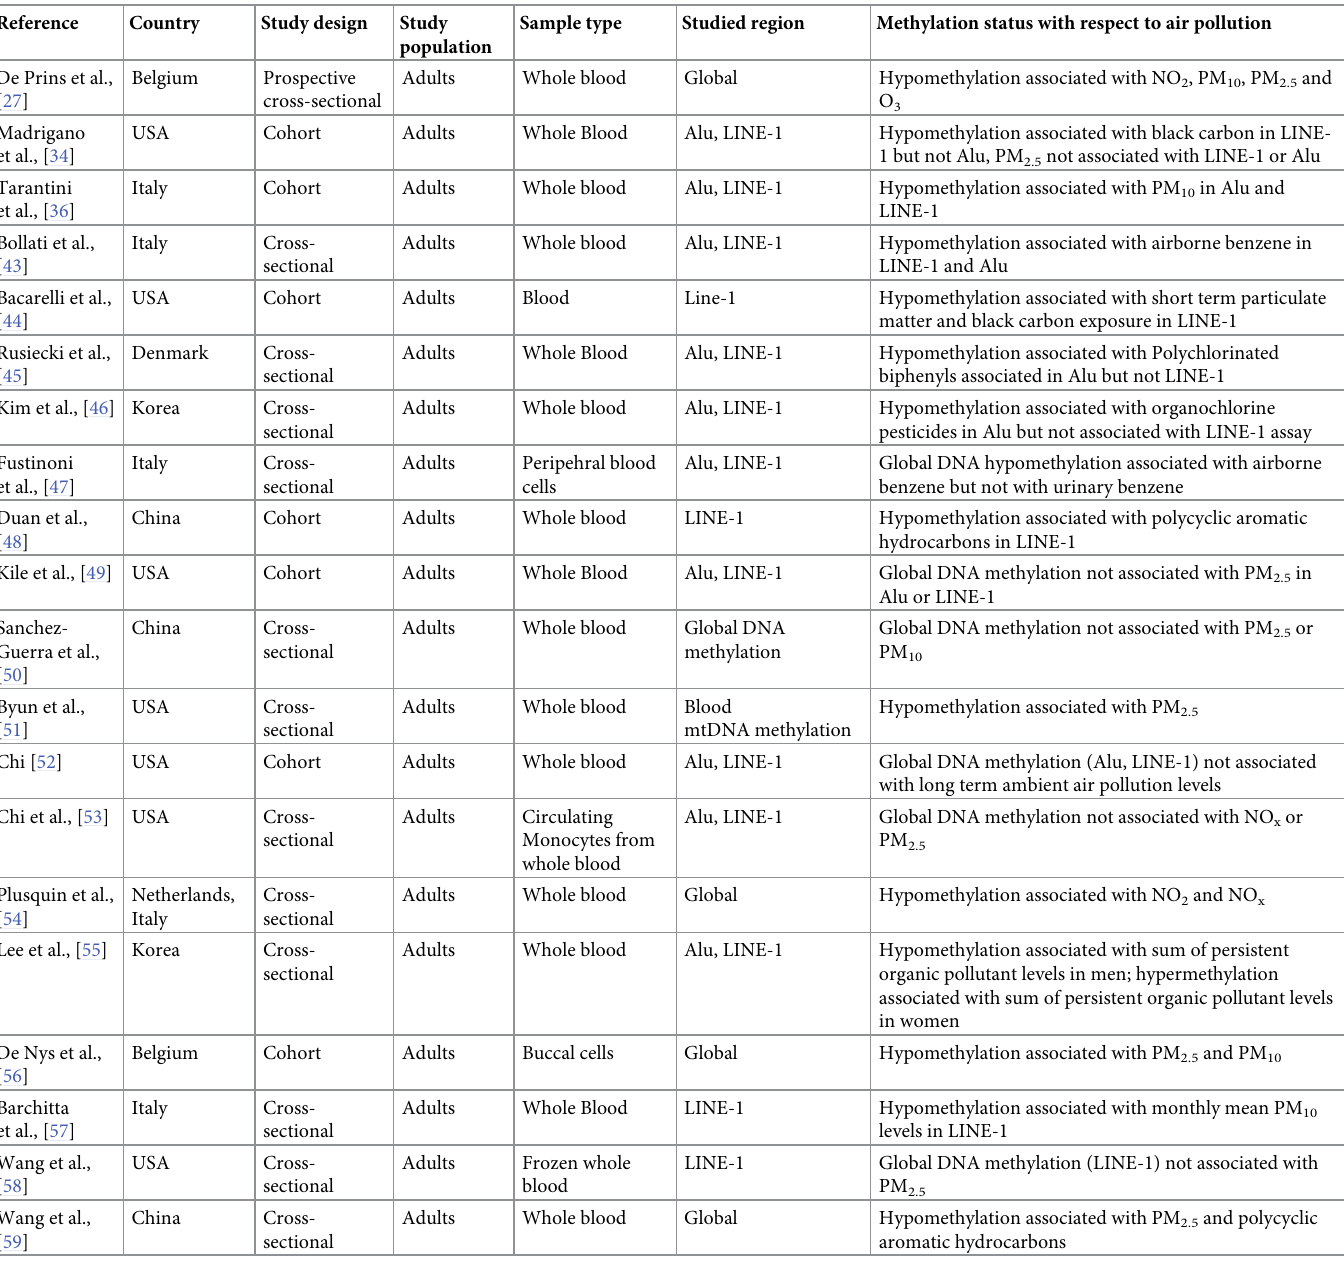
Table 5. Studies reporting relation between air pollution and global DNA